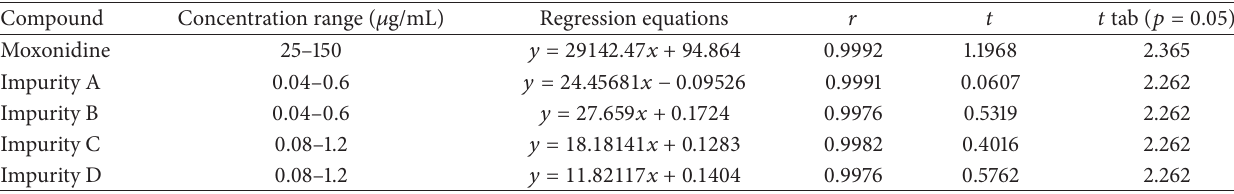
Figure 4: The chromatograms showing the estimation of method selectivity: (a) a chromatogram of placebo solution; (b) a chromatogram of standard mixture. Table 3: Statistical data for the calibration curves.